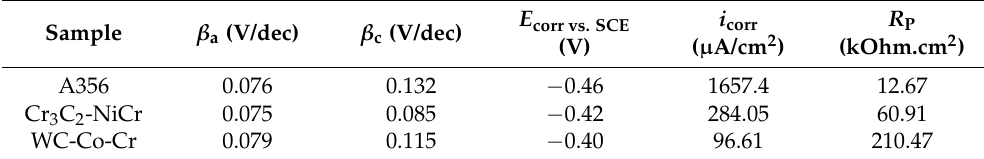
Table 3. The obtained results from the extrapolation of polarization curves.